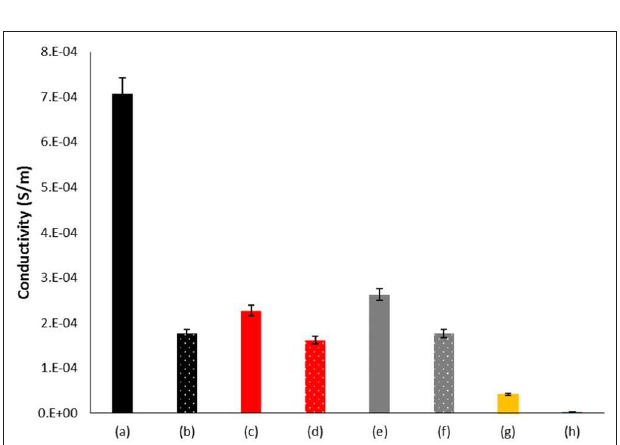
FIGURE 3 | Electrical conductivity of BC coated with PANI after oxidation under different conditions; (a) BC + aniline + AOT + KHCF + laccase; (b) BC + aniline + AOT + KHCF; (c) BC + aniline + KHCF + laccase; (d) BC + aniline + KHCF; (e) BC + aniline + AOT + laccase + ; (f) BC + aniline + AOT; (g) BC + aniline + laccase; (h) BC + aniline.